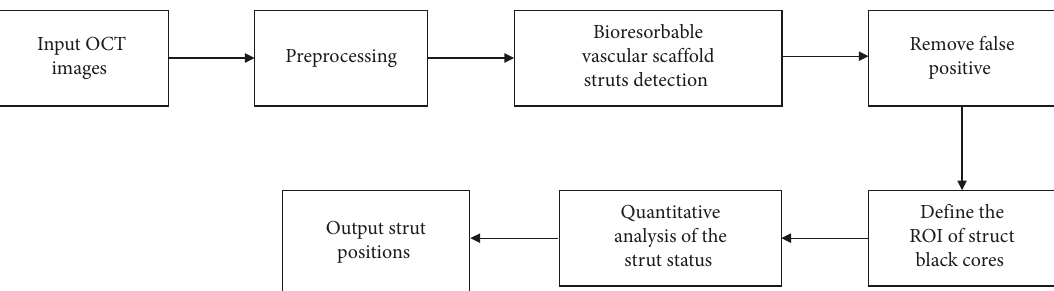
Figure 3: Flowchart of the automatic stent extraction algorithm.